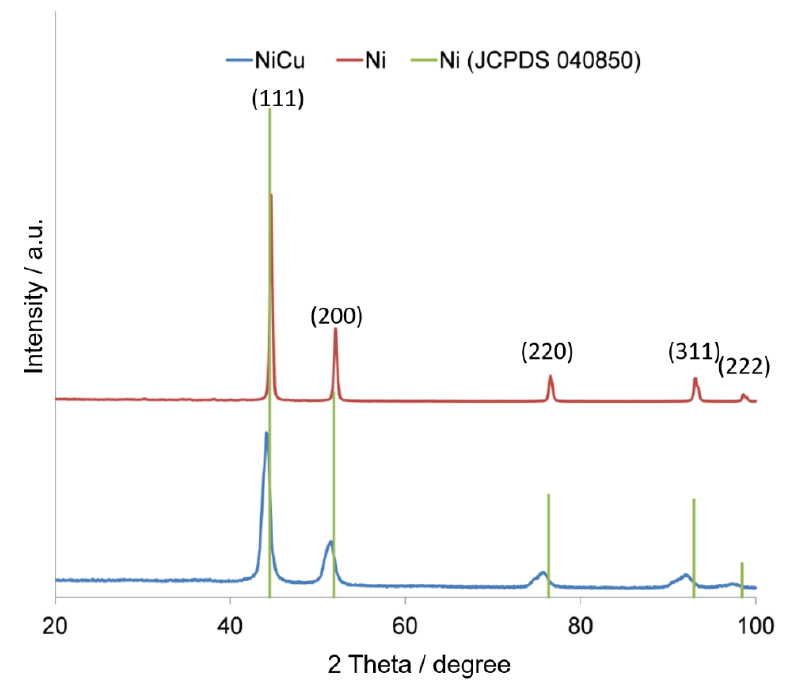
Figure 2. XRD patterns of in-house-synthesized Ni and NiCu catalysts.